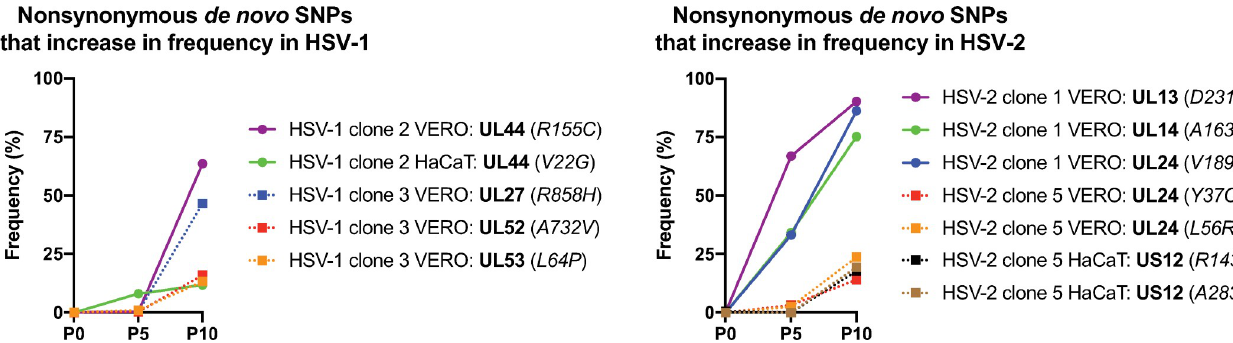
Fig 6. Dynamics of nonconservative de novo variants in each HSV-1 (left) and HSV-2 purified populations (right), whose frequency increased over sequential passages in cell culture. Nonsynonymous de novo SNPs were plotted by their frequency in the sequenced viral population after five (P5) and ten (P10) passages in Vero and HaCaT cells. SNPs, their encoded proteins (bold), as well as the change that they would cause in the translated protein (italic), are listed in the legend according to their frequency at P5 and P10.